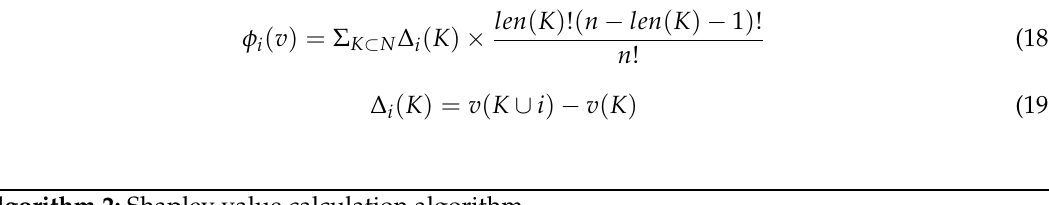
Algorithm 2: Shapley value calculation